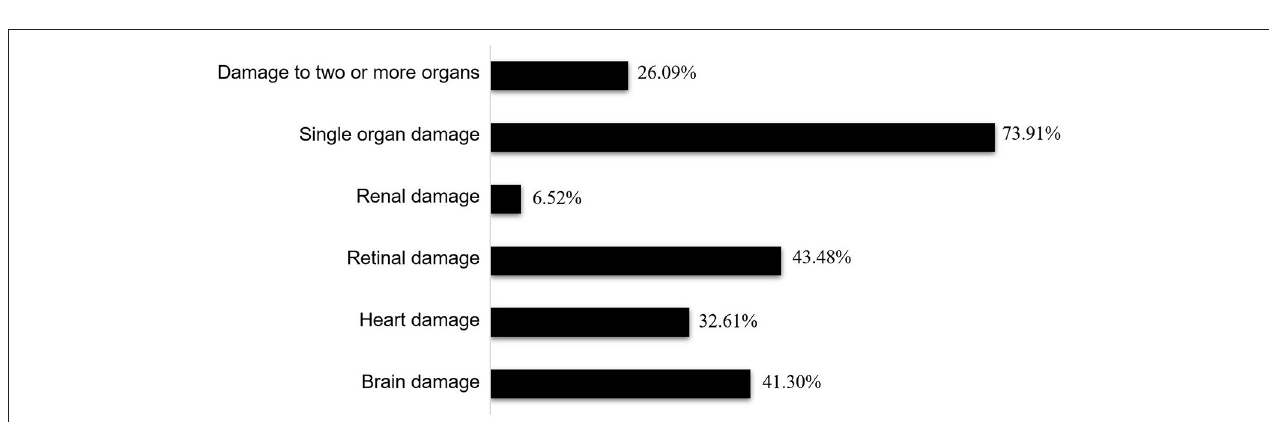
FIGURE 4 | Ratios of end-organ damage in the hypertensive emergency group. Among the 46 patients with hypertensive emergency, 12 (26.09%) had damage to two or more organs while 34 (73.91%) had damage to one organ. Damages to the retina (20 cases, 43.48%) and brain (19 cases, 41.30%) were most frequent, followed by damage to the heart (15 cases, 32.61%), with the kidney (3 cases, 6.52%) being the least affected.